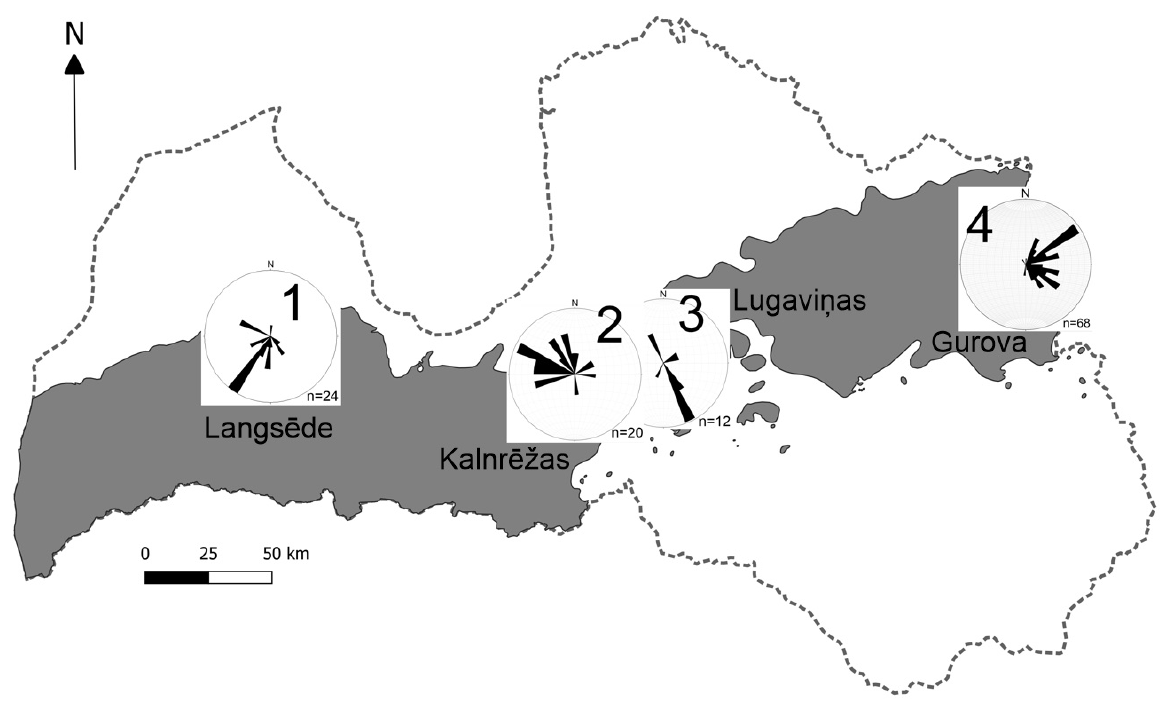
Fig. 5. Map of Latvia with the distribution area of the Ogre and Katleši formations (in grey colour; according to the bedrock mapping of Latvia at a scale of 1:200 000 (1998–2004); State Geological Survey of Latvia) and rose diagrams of current directions derived from measurements of cross­bedding and ripple­lamination: 1, data from the Langsēde site (Lukševičs et al. 2011); 2, data from the Kalnrēžas site (unpublished materials of A. Vasiļjevs); 3, data from the Lugaviņas site (unpublished materials of A. Vasiļjevs); 4, data from the Gurova Ravine (this study). Distribution areas of the Ogre and Katleši formations are not divided because these formations were mapped as unified in eastern